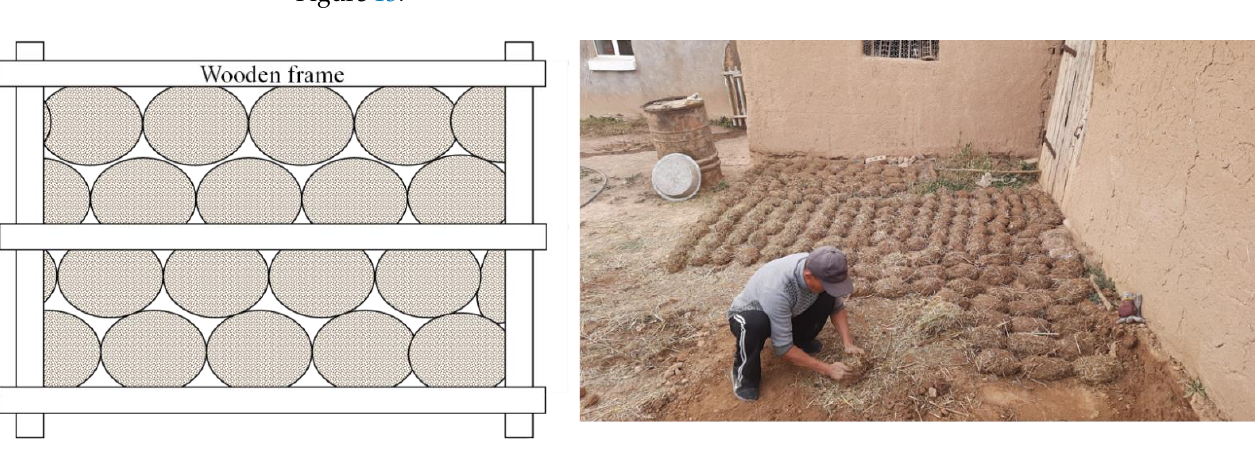
Figure 13. A wall structure with clay lumps and a wooden frame ( left ) and clay lumps in prepara- tion ( right ).